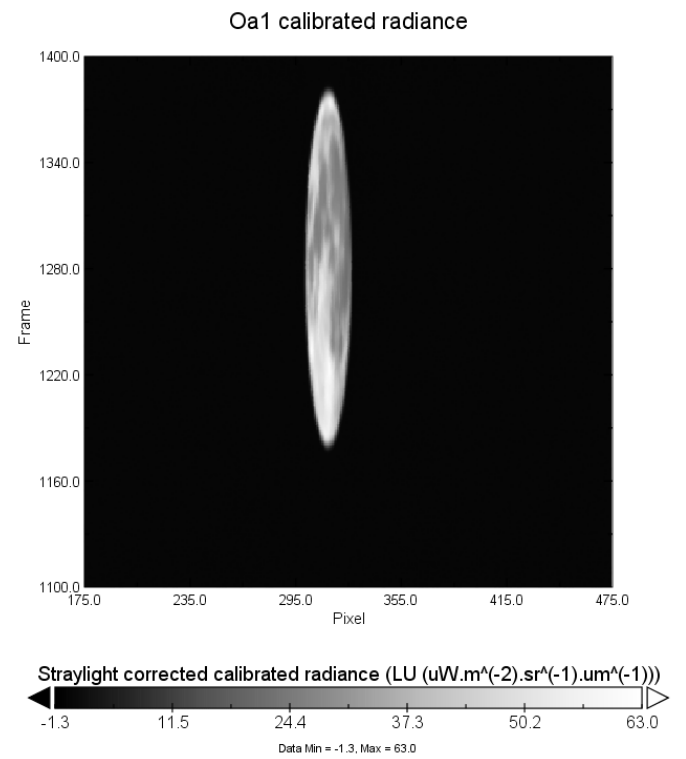
Figure 9. Radiance imagette from OLCI camera 4, band Oa1 moon scan shows the oversampling effect on moon data. Image is 300 × 300 pixels with ACT direction on X ‐ axis.